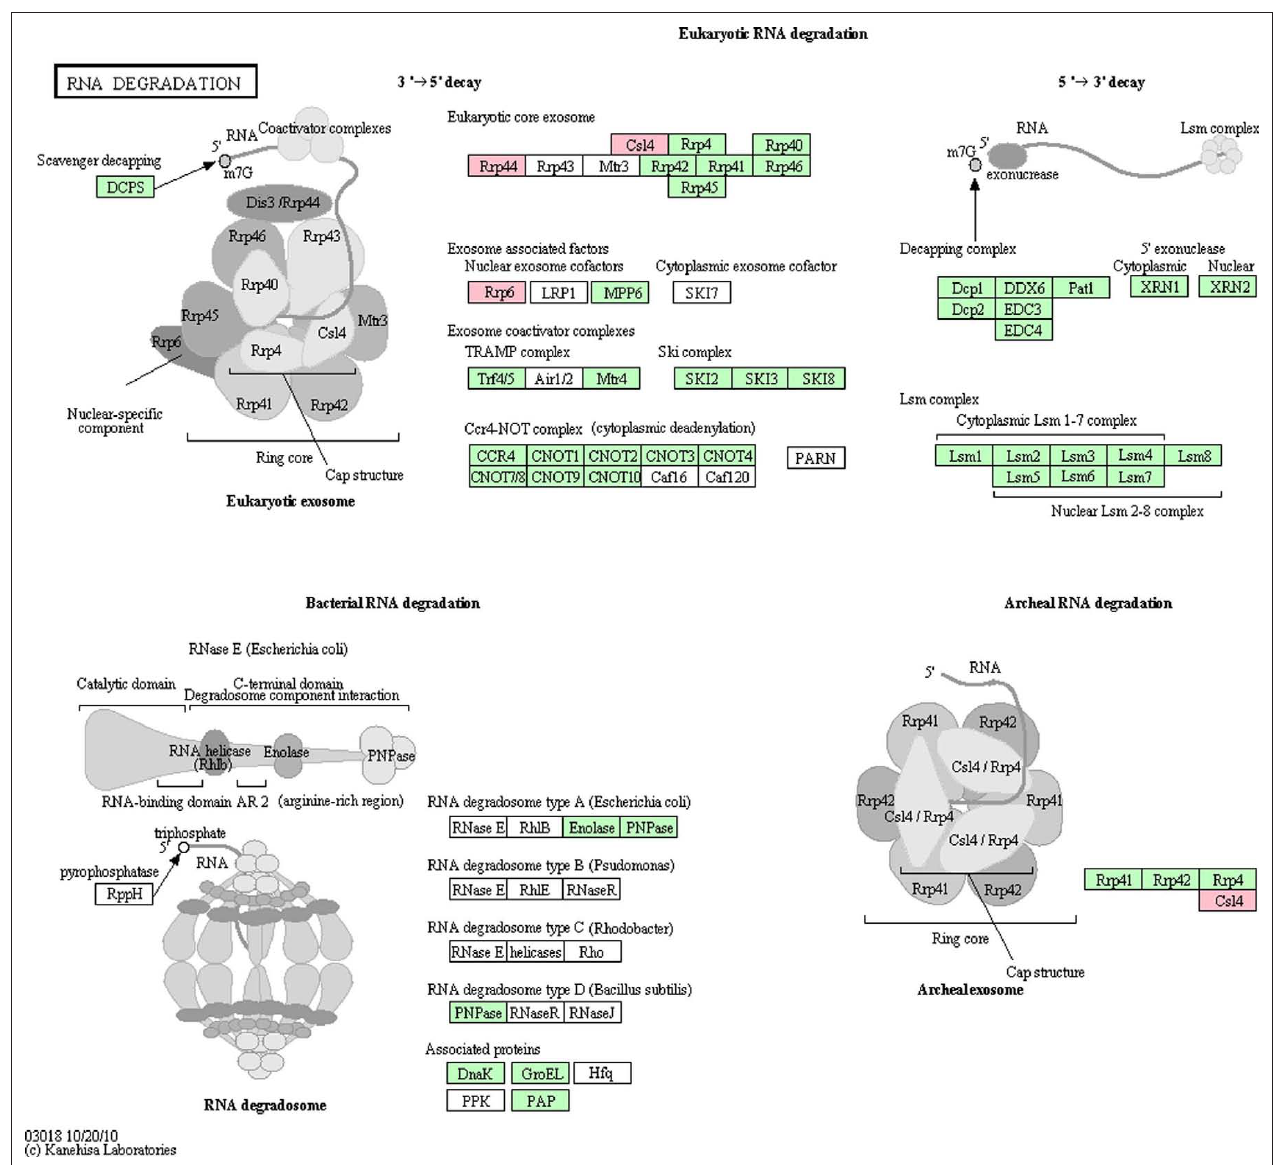
product from transcript CG6413-RA), and Rrp6 (CG7292 gene product from transcript CG7292-RB). Green boxes represent other members in the pathway database for Drosophila melanogaster